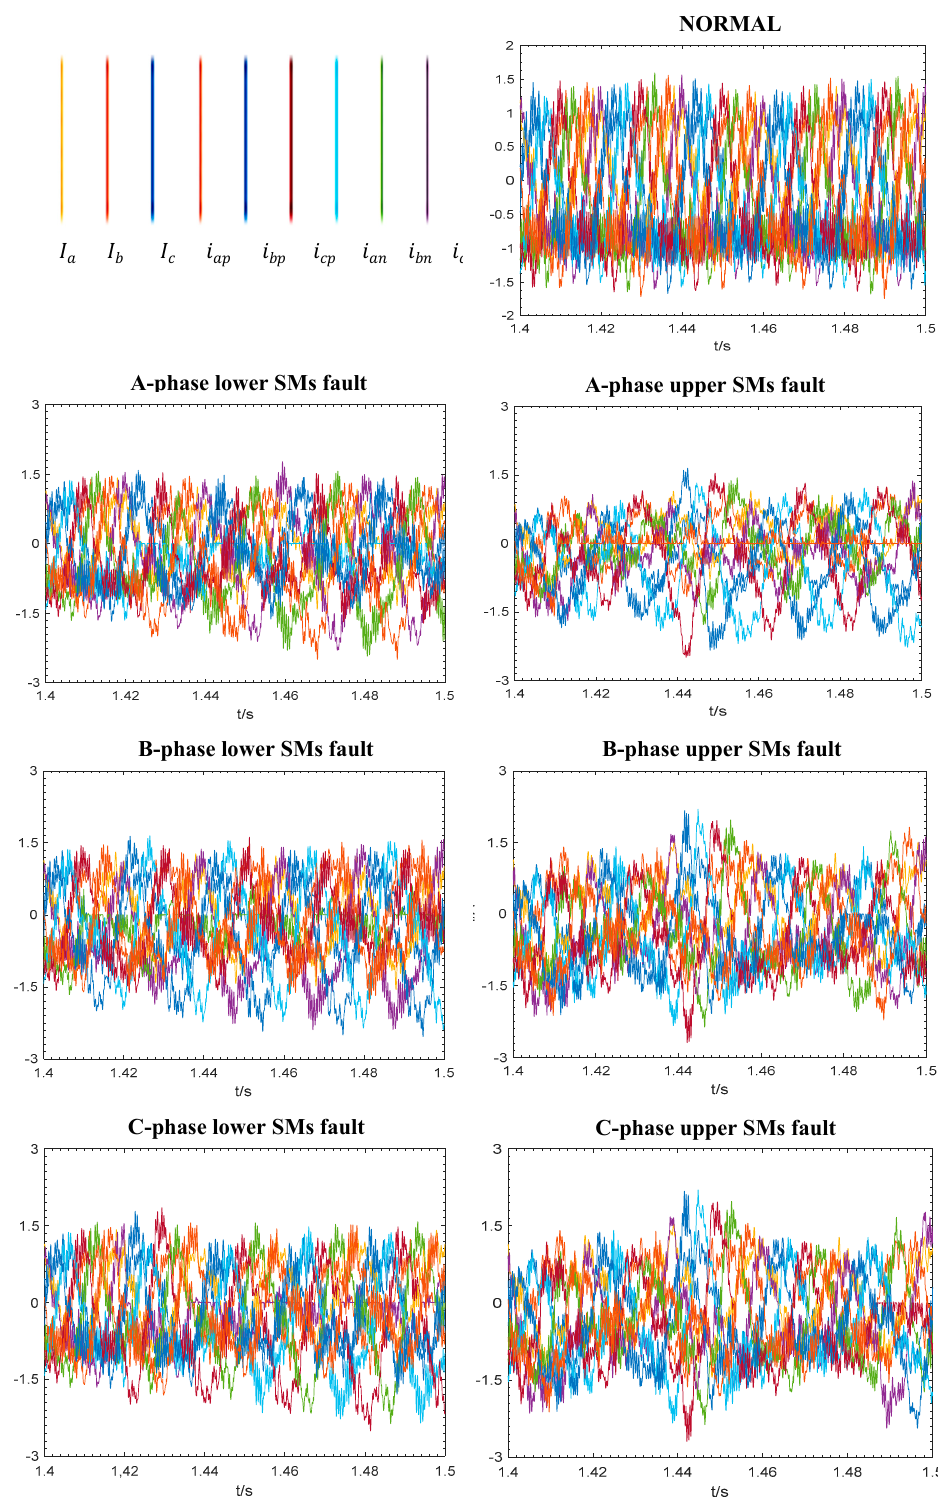
Figure 3. Typical time series plots for seven different conditions as shown in Table 3.